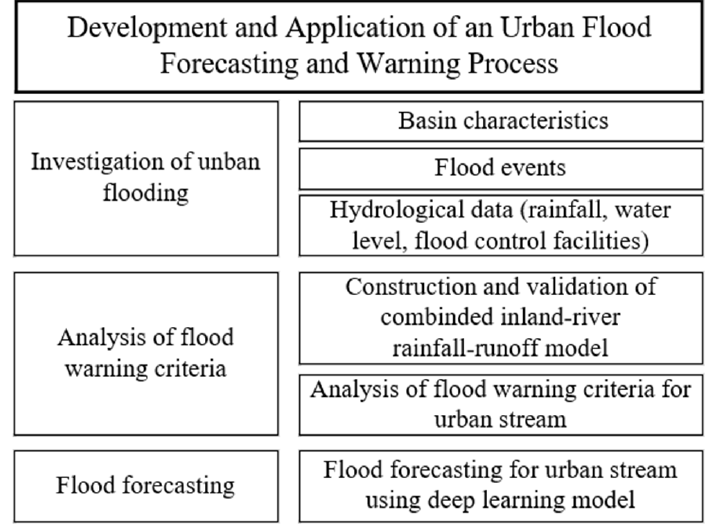
Figure 1. Urban flood forecasting and warning process.